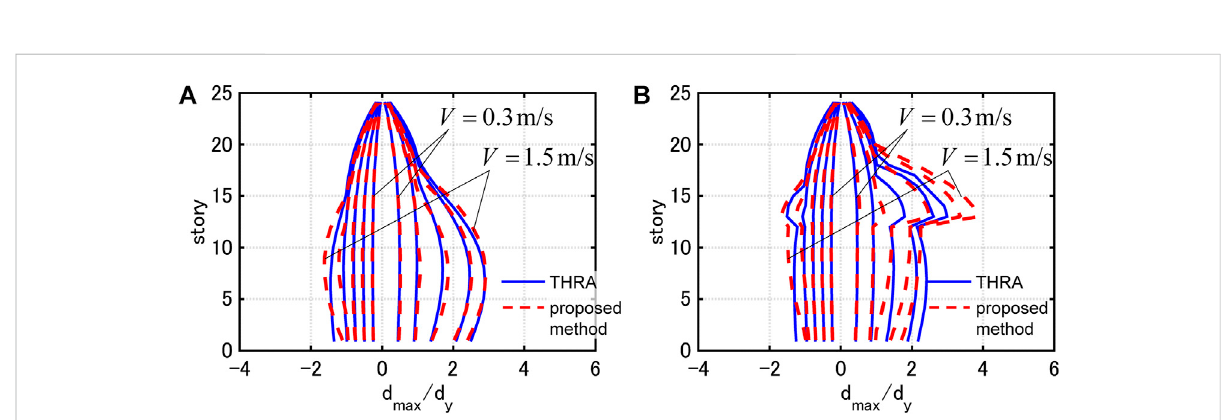
FIGURE 14 Maximum interstory drifts under corresponding one-cycle sine wave and those evaluated by proposed method, (A) Model 1, (B) Model